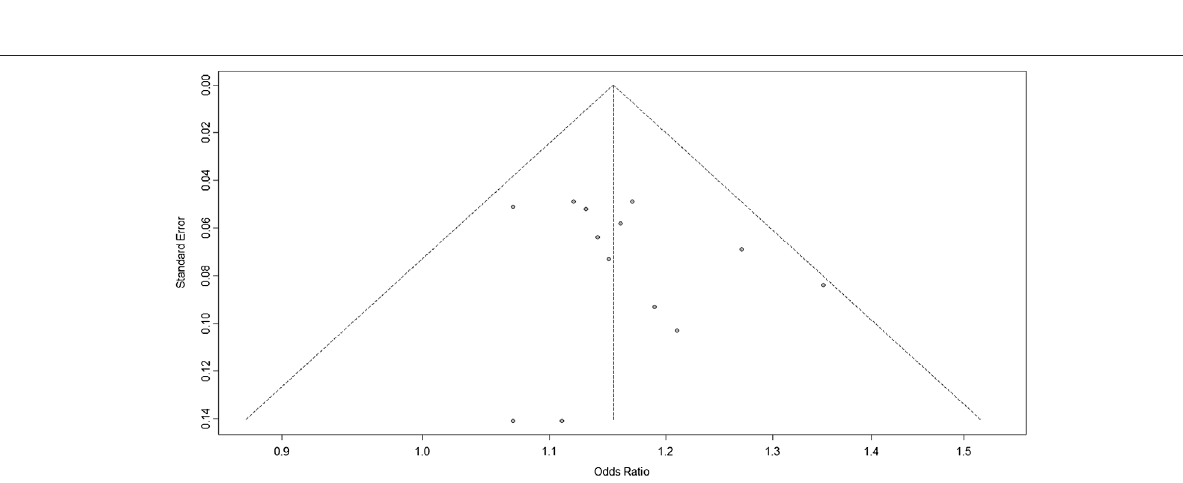
Frontiers in Genetics |